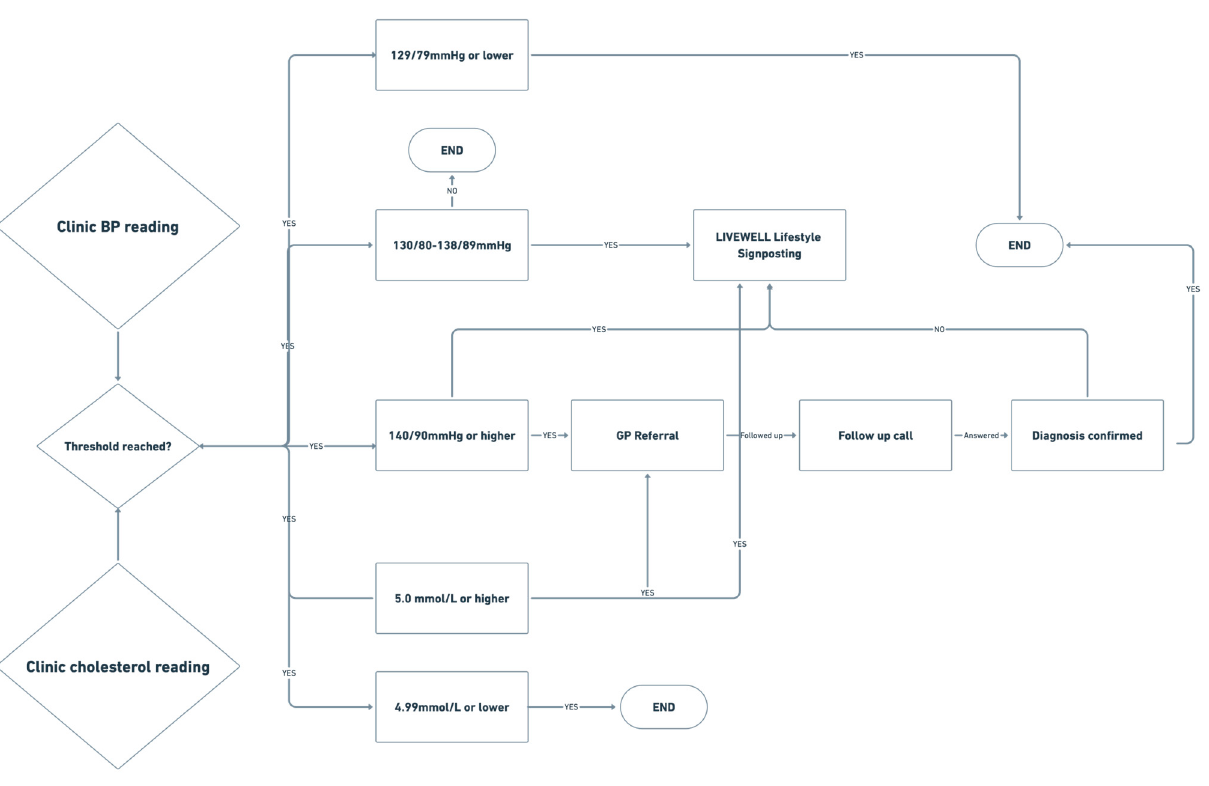
Figure 3. Referral pathways involving the GP and support services after participants received their blood pressure and cholesterol measurements. GP—general practitioner, BP – blood pressure.